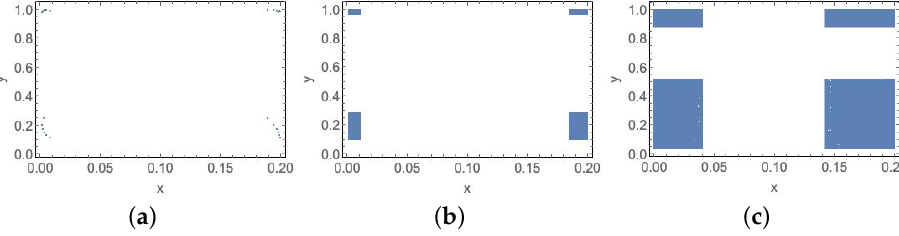
Figure 21. ω -limit sets for Cournot duopoly when the competitors operate under capacity constraints. Initial conditions x 0 = 0.2 and y 0 = 0.3. The longitude orbit is equal to 200000 and the last 100000 points have been plotted. ( a ) u = 1 and v = 8.137; ( b ) u = 1 and v = 8.151; ( c ) u = 1 and v =